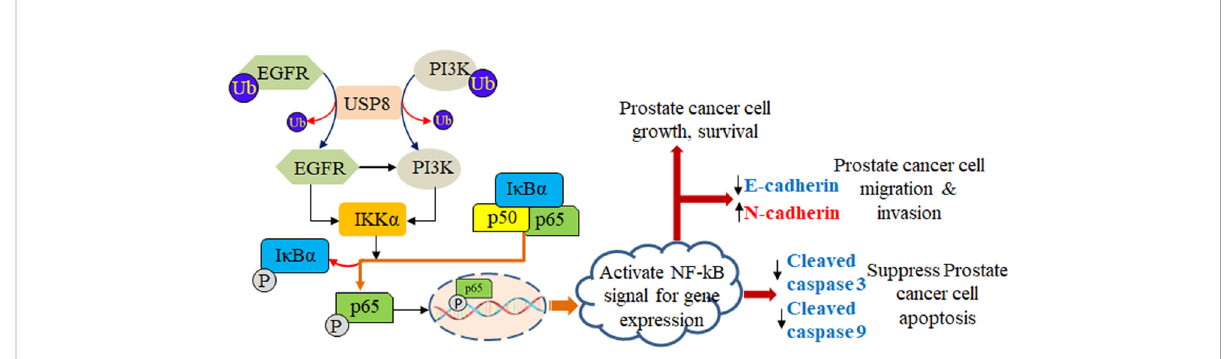
FIGURE 7 Role of USP8 in prostate cancer. USP8 stabilizes both EGFR and PI3K, which leads to elevation in the expression of IKK a . The elevated IKK a phosphorylates IkB a and dissociates p65 from IkB a and is translocated into the nucleus acting as a transcription factor that activates the